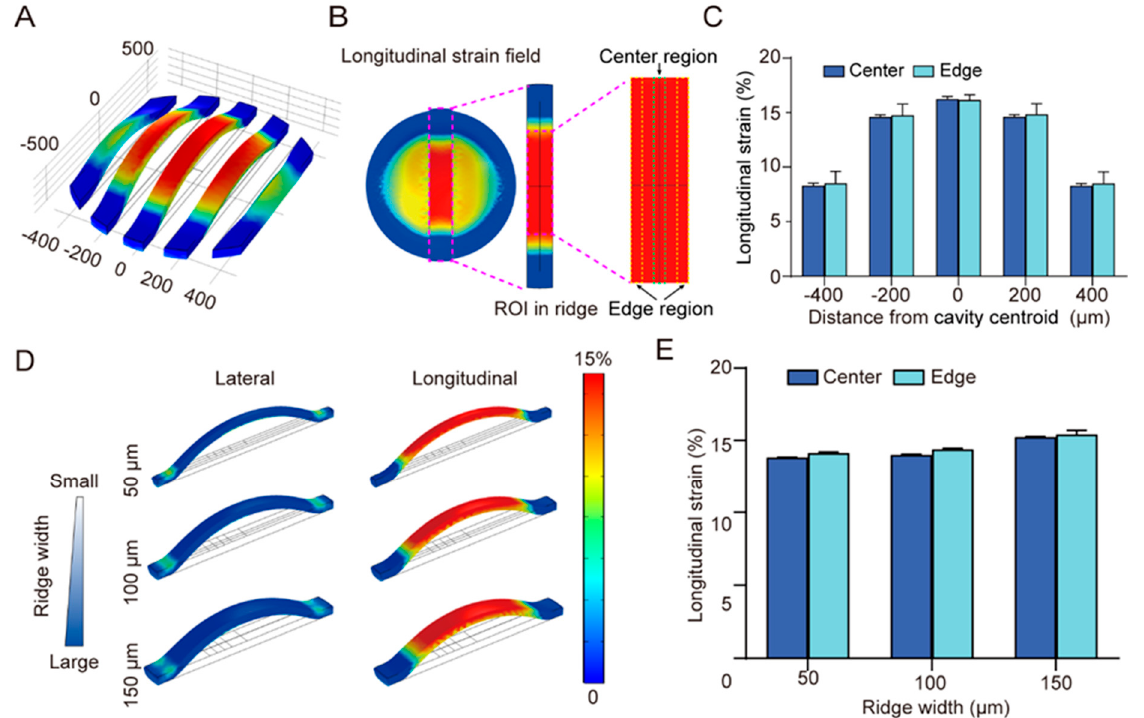
Figure 4. Uniaxial strain property is independent of the ridge location in a pressure cavity and the ridge width. ( A ) Longitudinal strain field distribution in all of the ridges within one pressure cavity. The diameter of the pressure cavity is 1000 μ m. The width of ridge is 100 μ m. ( B ) Center and edge regions of interest (ROIs) in a ridge represent the regions that were used for analyzing the longitu ‐ dinal strain. ( C ) Bar plot showing the longitudinal strain of the center and edge regions in the ridge indicated in ( A ). ( D ) Lateral and longitudinal strain field distributions in a ridge with a width of 50, 100, and 150 μ m under 0.8 bar pressure. ( E ) Bar plot showing the quantitative data of the longitudi ‐ nal strain of the center and edge regions (indicated in A) in a ridge with different widths.